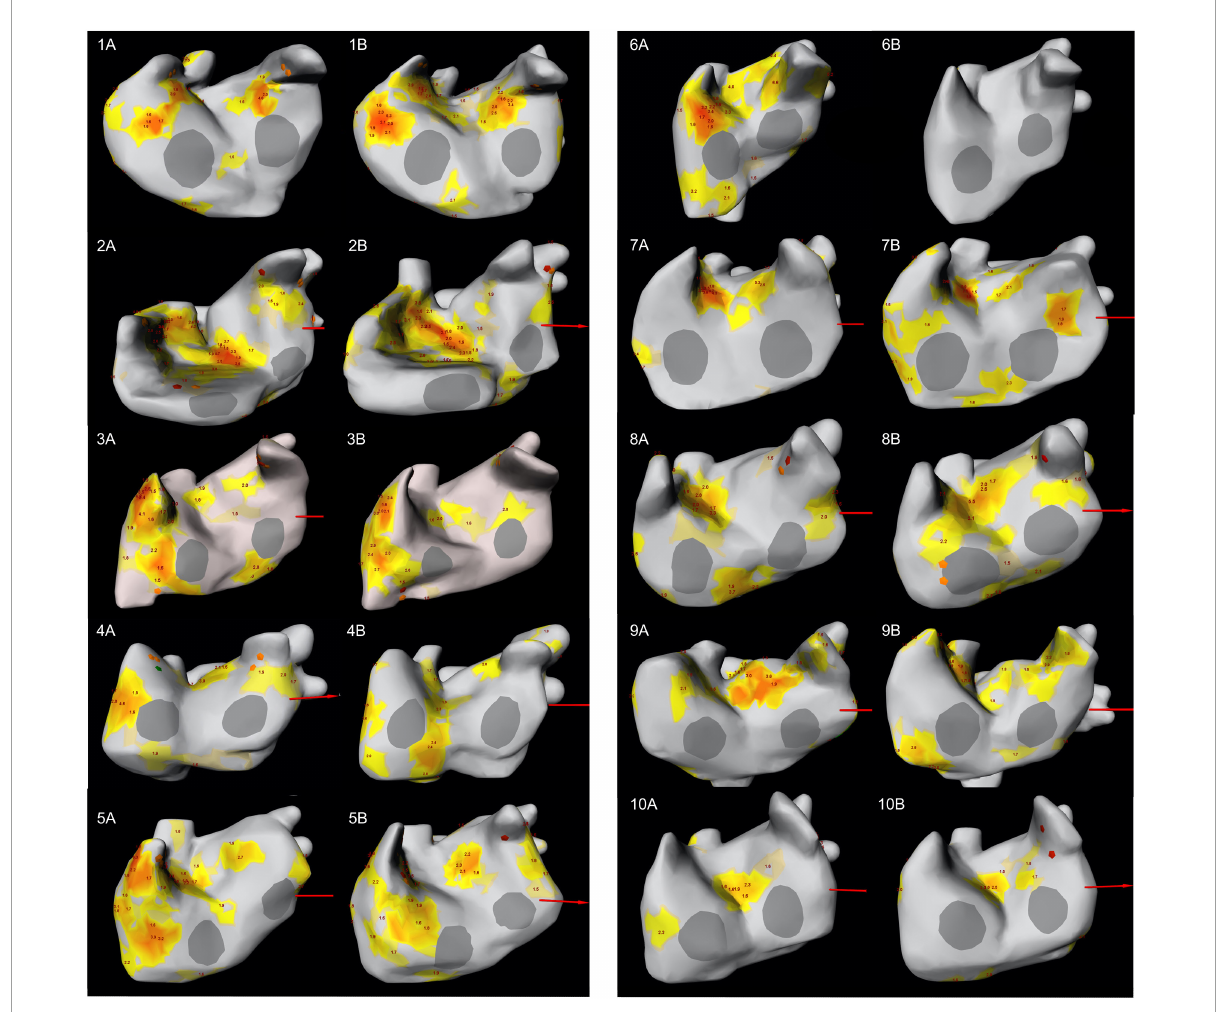
FIGURE3 LAO-view showing the distribution of focal and rotor activity of all 10 patients in both mappings. The number indicates the patient number; letter (A) indicates the first mapping, letter (B) indicates the second mapping. Focal activity can be recognized as orange diamond while rotor activity is depicted as yellow/orange area. The number at the area’s center indicates the number of rotations. LAO, left anterior oblique.